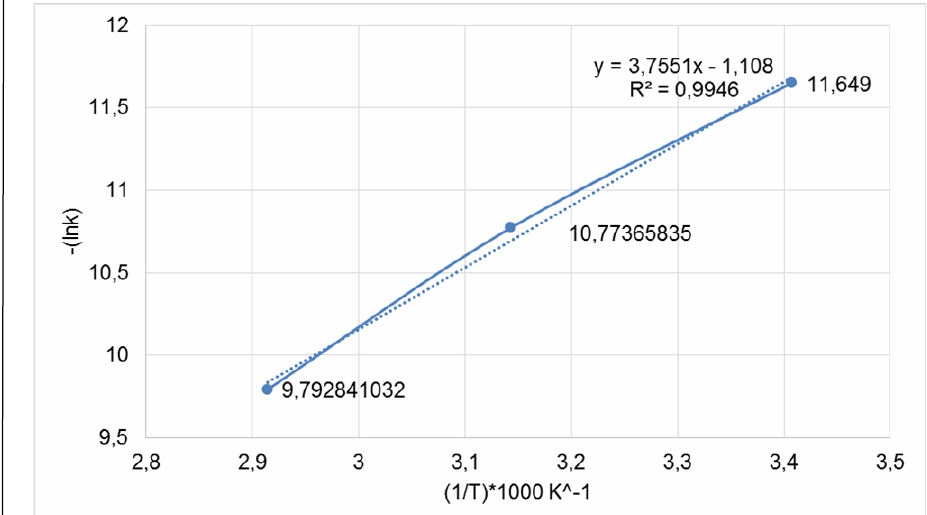
Figure 8 – Arrhenius plot for the dissolution of yttrium with hydrochloric acid between 20°C and 70°C Рис . 8 – График уравнения Аррениуса для растворения иттрия в соляной кислотойе при температуре 20 ° C - 70 °